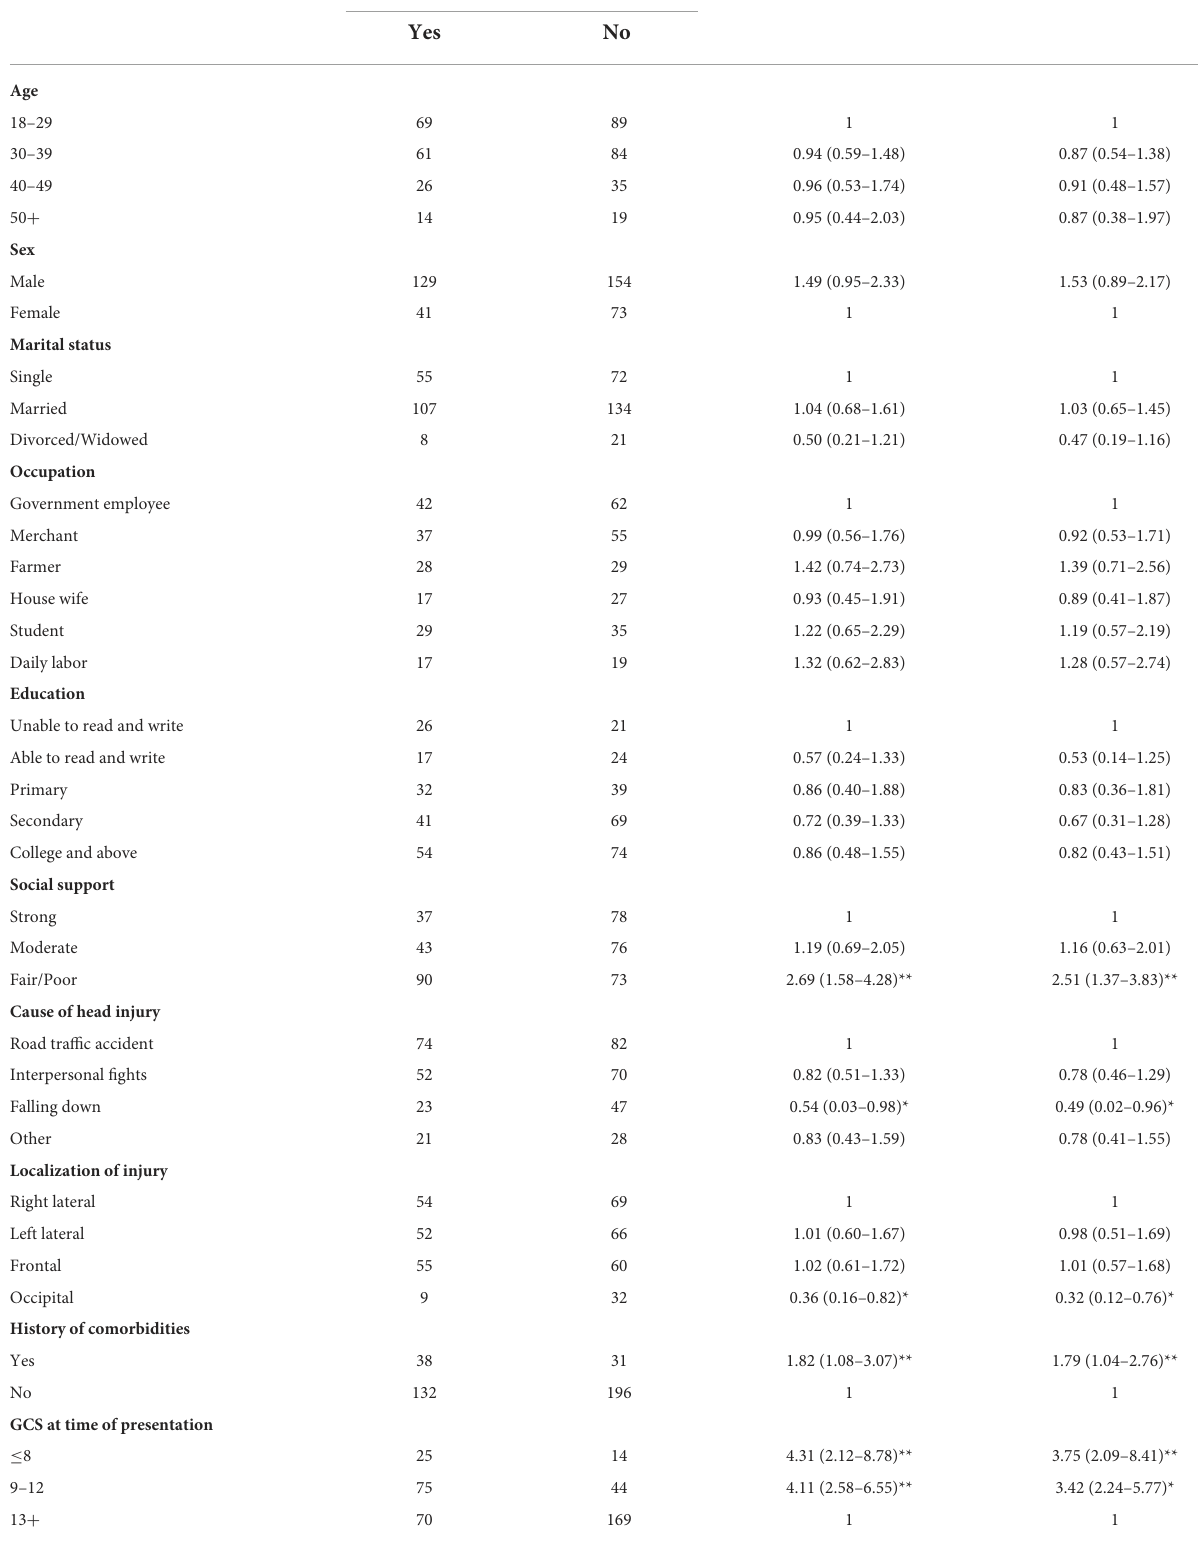
TABLE 3 Factors associated PCS (bivariate and multivariate logistic regression) of study participants attending emergency outpatient department of Debre Tabor Compressive Hospital, Debre Tabor, Ethiopia ( n = 397).